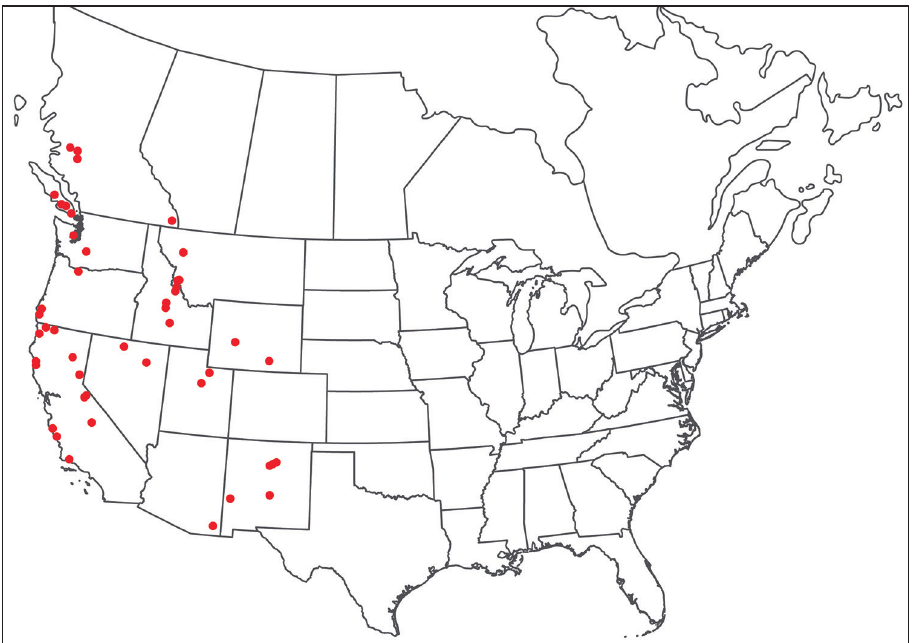
Figure 158. Torrenticola multiforma